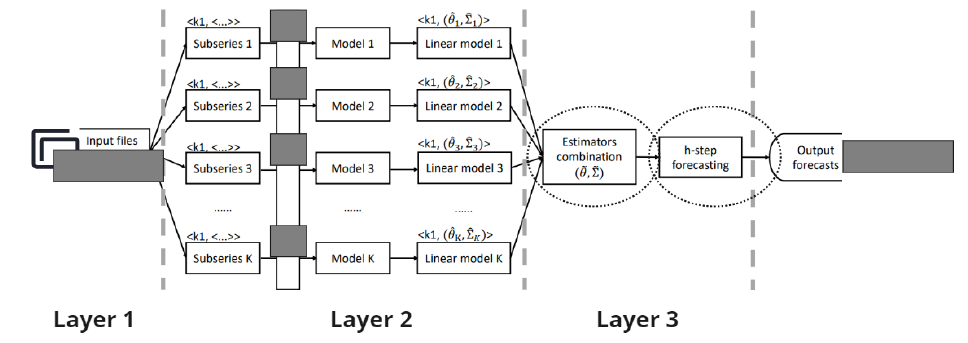
Figure 12. The ARIMA